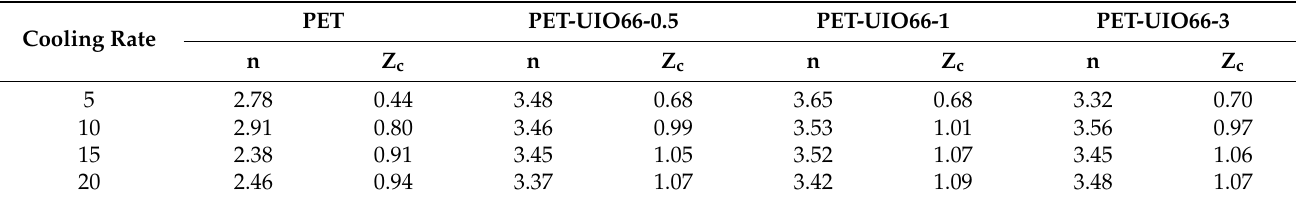
Table 3. Thermal behaviors of PET and PET/UIO-66 nanocomposites obtained from DSC.